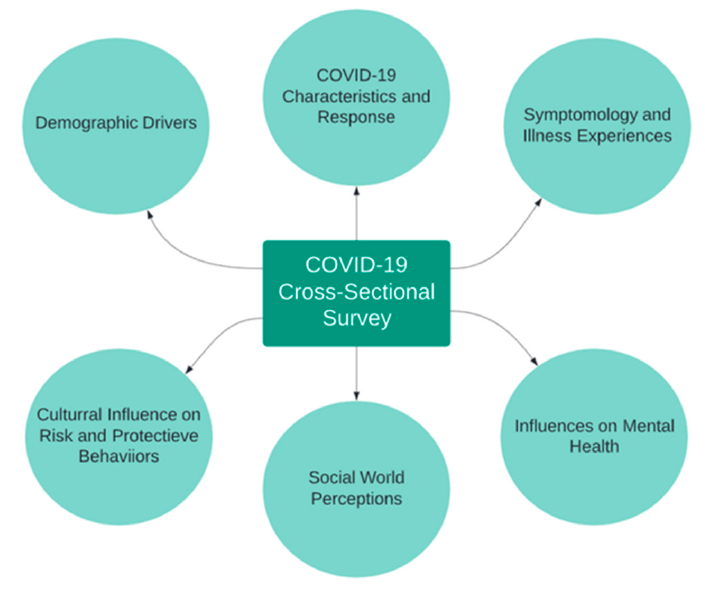
Figure 1. Cross-sectional survey flow of student perceptions examined through self-report.